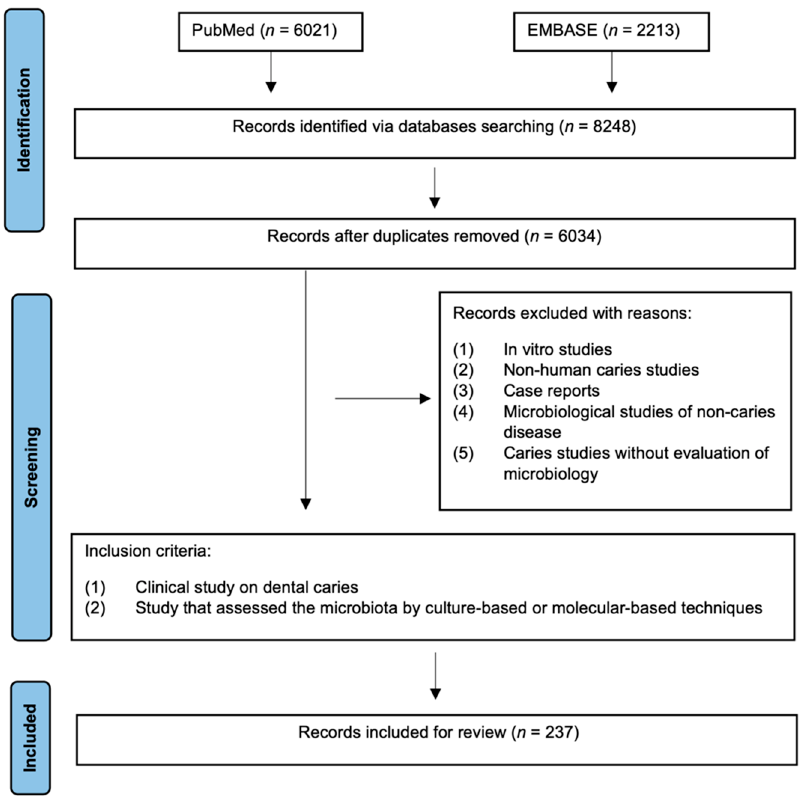
Figure 1. Flow diagram of literature search and study selection.